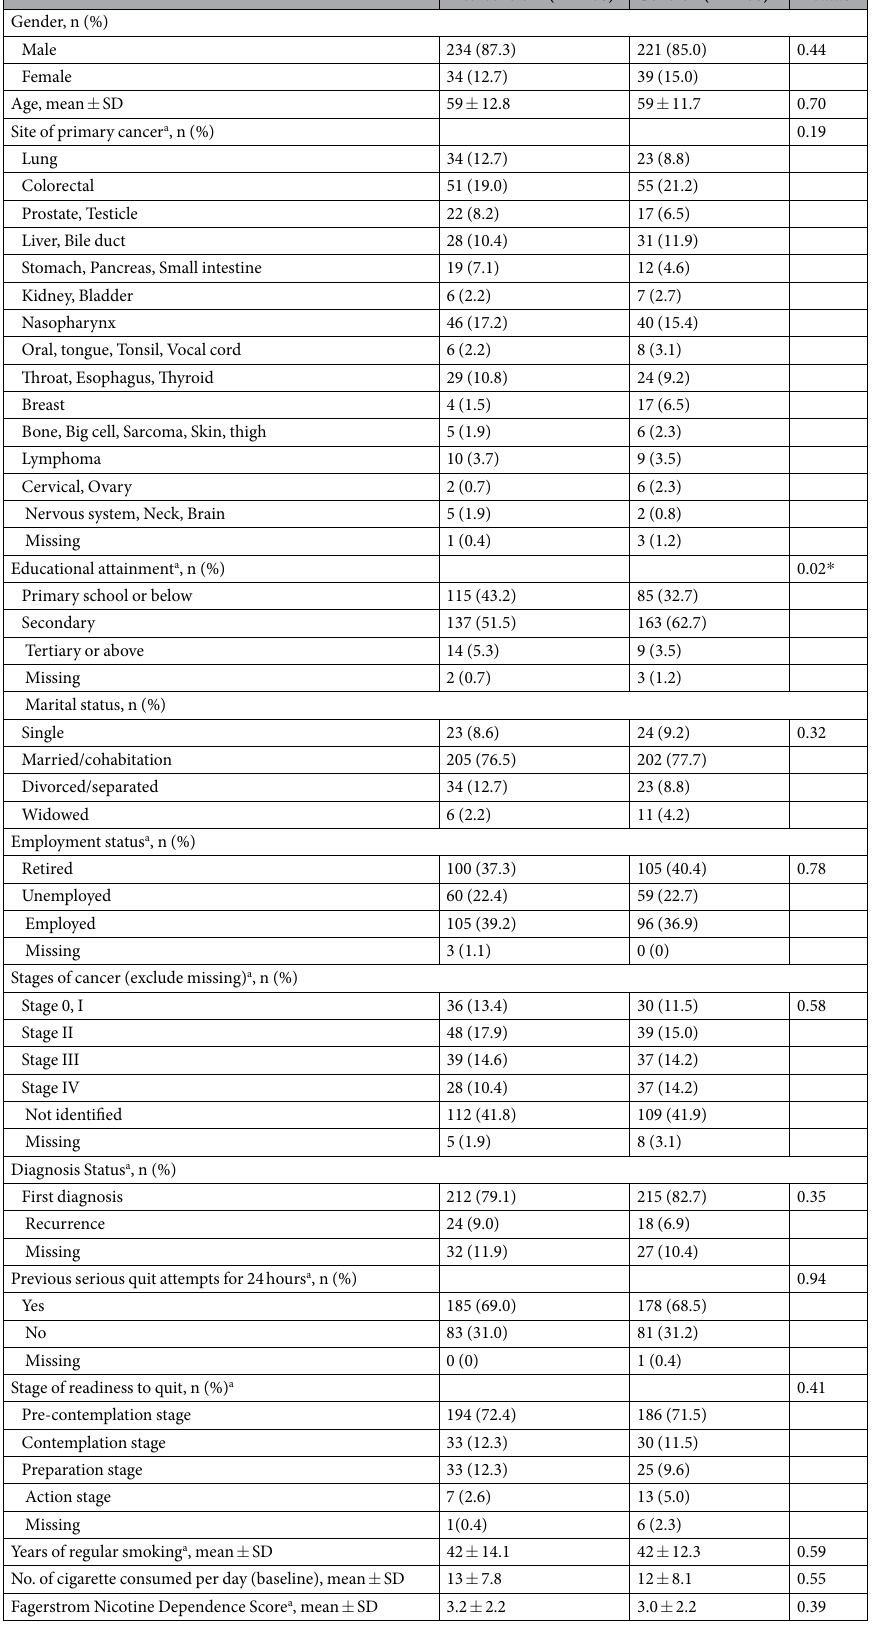
Table 1. Baseline characteristics of the subjects. a Missing data are excluded. b Brief advice based on risk communication. c Usual